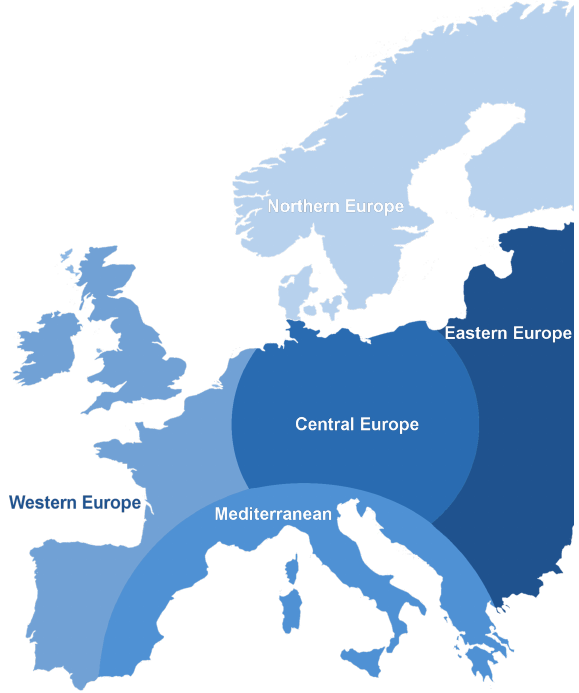
Figure 3. European sub-regions used in this review: Atlantic west- ern Europe and northern Europe, Continental central Europe and eastern Europe, and the European